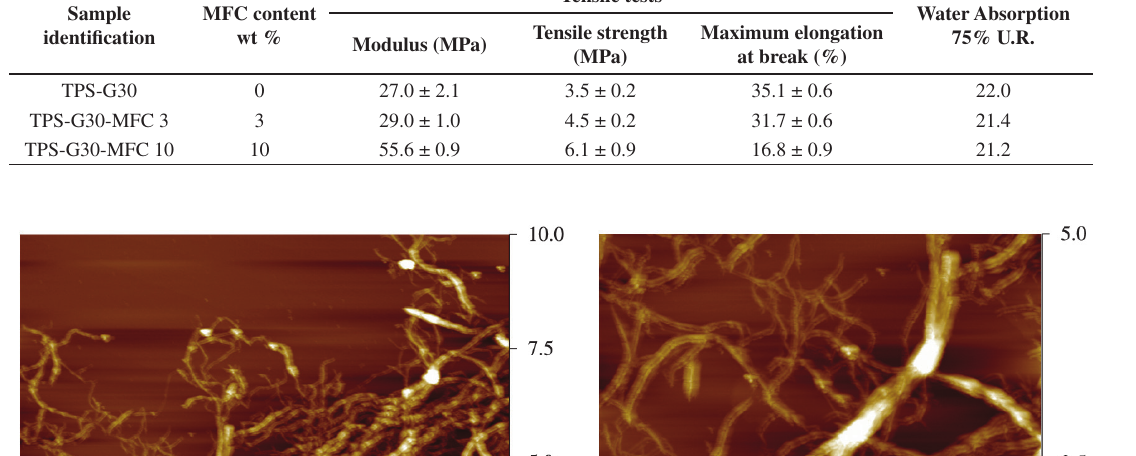
Table 1. Composition code names, MFC content and mechanical and water absorption properties of the matrix and nanocomposite materials. Sample identification